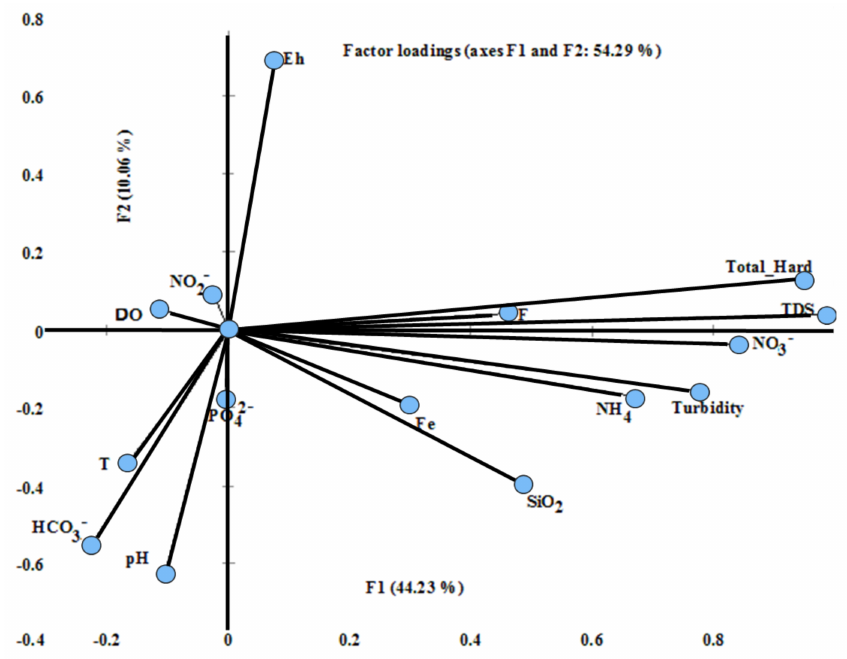
Figure 7. Contributions of quality parameters to groundwater data variances plotted on the loading space of primary factor (F1) versus